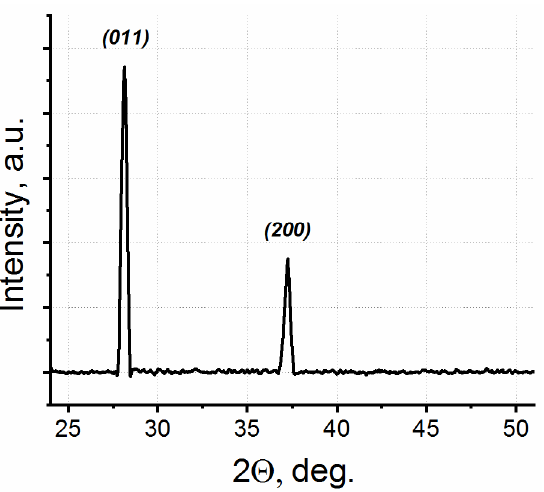
Figure 2. The X-ray diffraction spectrum of the horizontally and vertically oriented VO 2 NWs synthesized on the nanoimprinted Si substrate.